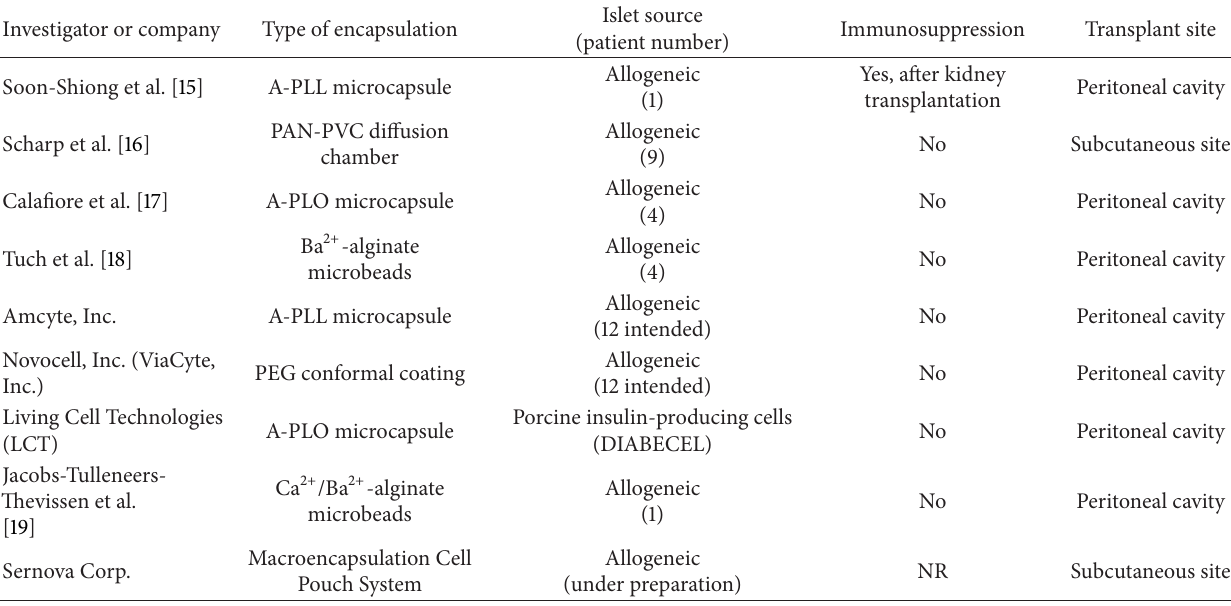
Table 3: Encapsulated islet transplantation in patients with